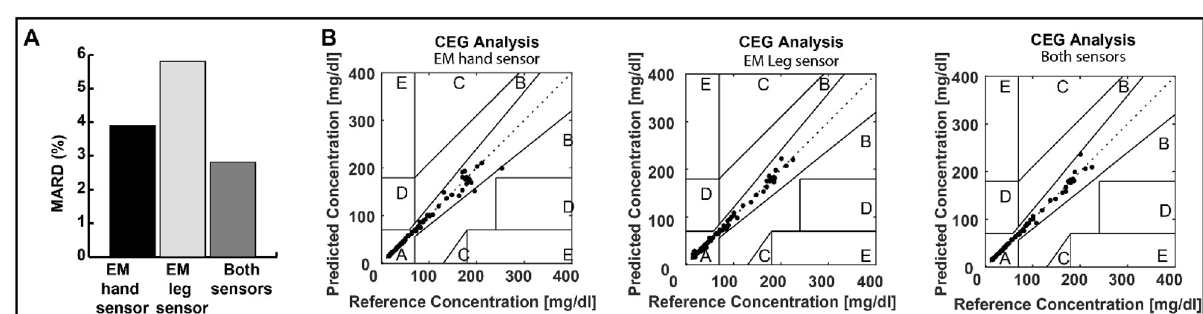
Figure 6. Comparison between the performance of the leg and hand EM sensors for the conducted experiments on three carried out on 10 healthy subjects and 18 patients with diabetes. Signals from the hand and EM leg sensors along with the integrated environmental sensors were monitored, while varying the blood glucose levels, during a two- hour OGTT for everyone. One of the study goals is to check the effect of the ambient temperature, humidity, skin temperature, galvanic skin response and, movement on the RF-signal and to compensate for these perturbations. The responses, towards the variation of glucose levels, collected from on-body readings during one OGTT using the multi-sensing system are detailed in Fig. 7. Normalized data collected from the environmental/physi- ological sensors: skin temperature, humidity, ambient temperature, GSR and motion in terms of X, Y and Z are measured as shown in Fig. 7A. Additional discussion is presented in supplementary note 11. These signals along with the S parameters collected from the EM leg and hand sensors, shown in Fig. 7B, are used to predict the glucose levels. Using the wrapper feature-selection technique, we can identify the important features for everyone by analyzing their data. A Gaussian process regression model 38,39 is adopted and each OGTT is processed separately. The comparison between the standalone and combined system in terms of mean percentage error of the glucose levels prediction shows that the multi-sensing system provided lower prediction error compared with the standalone system as displayed in Fig. 7C,D. In the same context, Fig. 8 shows a comparison between prediction errors for the EM hand sensor used alone, EM leg sensor used alone and the combined system. CEG for all the OGTT conducted by the 28 individuals for the standalone systems and the combined system. Additional results are provided in Supplementary Figs. S7–S10. All the estimated values are in the clinically acceptable zones A and B with the majority in zone A.